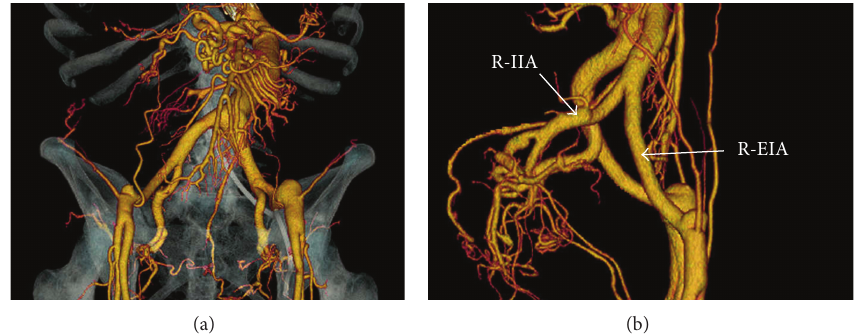
Figure 1: Three-dimensional computed tomography scan demonstrating no dissection or aneurysm in the iliac and external iliac arteries. (a) Anterior to posterior imaging. (b) Right-to left-sided imaging. R-IIA: right internal iliac artery; R-EIA: right external iliac artery.